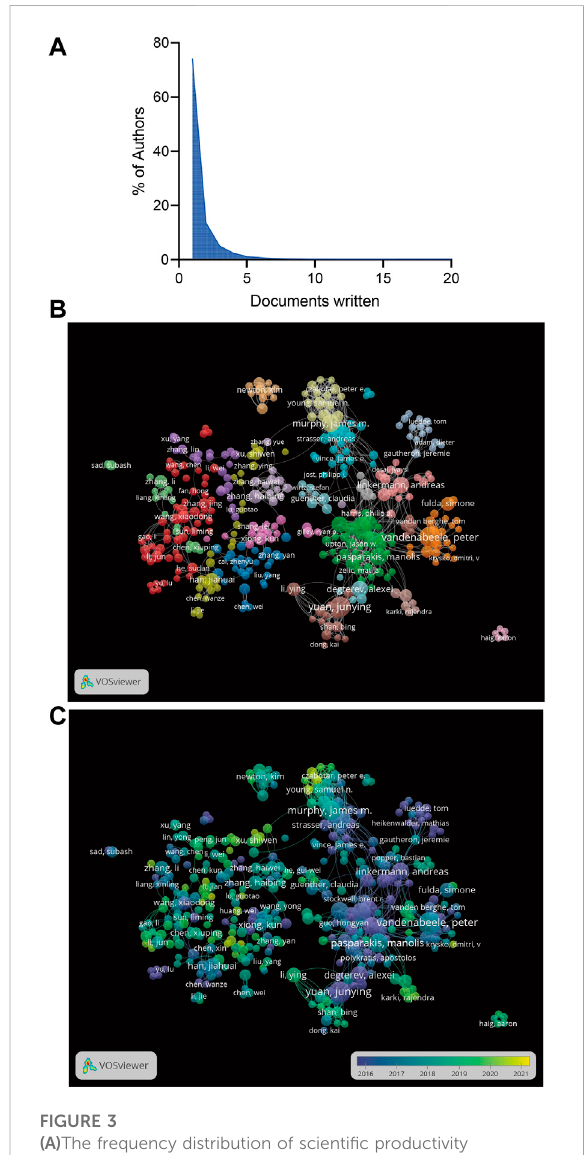
FIGURE 3 (A) The frequency distribution of scienti fi c productivity (Lotka ’ s Law). (B) The network map of authors for necroptosis research. (C) The overlay visualization of authors for necroptosis